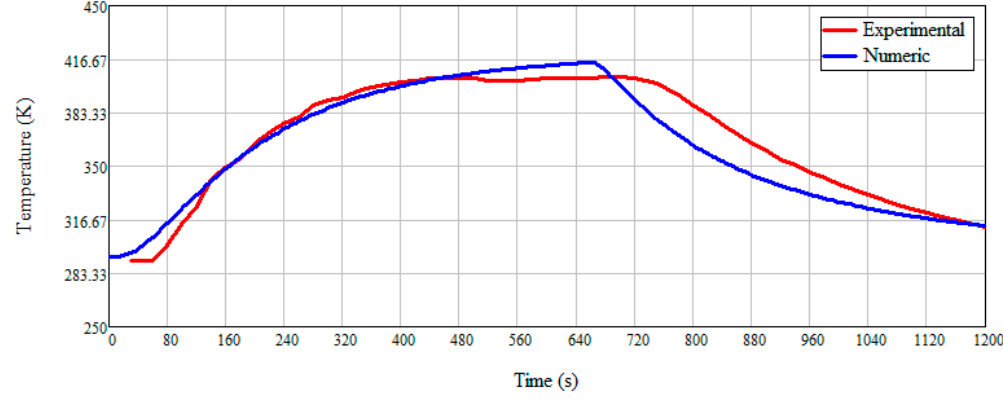
Figure 29. Maximum temperature variation on the second shield.